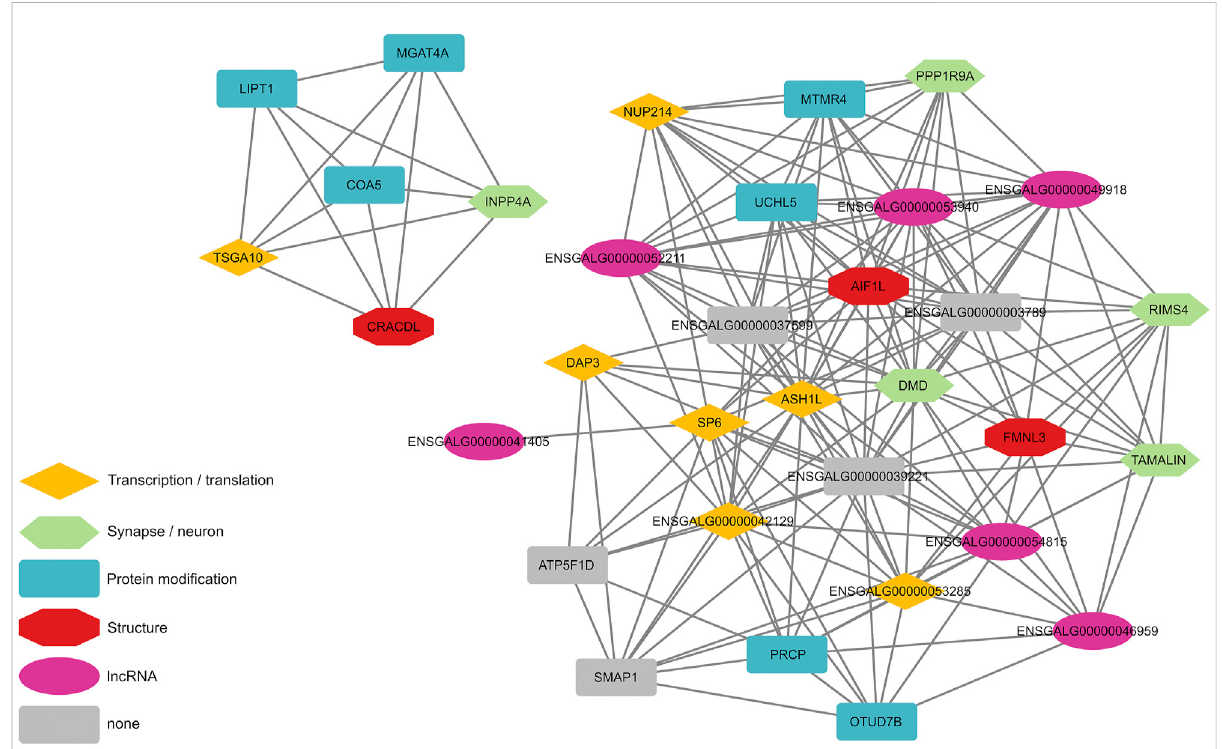
FIGURE 2 Signi fi cant gene-gene interactions, which were discovered with an association weight matrix followed by analysis with the PCIT algorithm. Input genes were derived from expression genome wide association studies with differentially expressed genes between high and low feather pecking chickens as